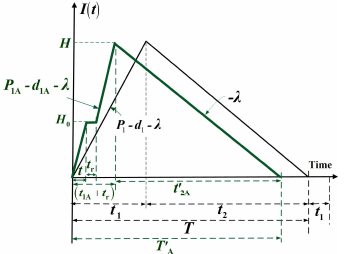
Fig. 2 .The on-hand status of safety stocks in the proposed system with expedited rate, random failures, and scrap